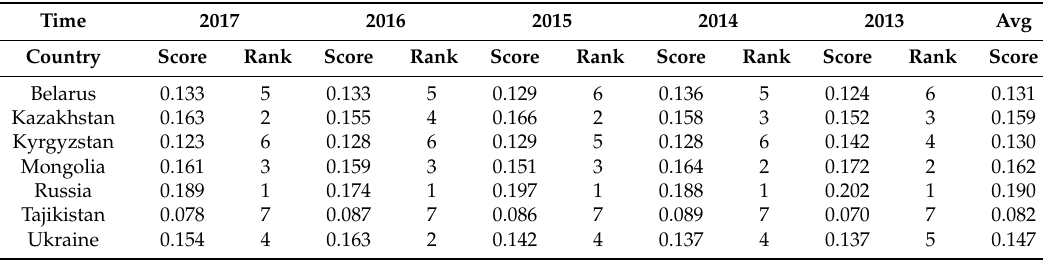
Table 3. Comprehensive rating and ranking of cross-border e-commerce investment climate of seven countries from 2013 to